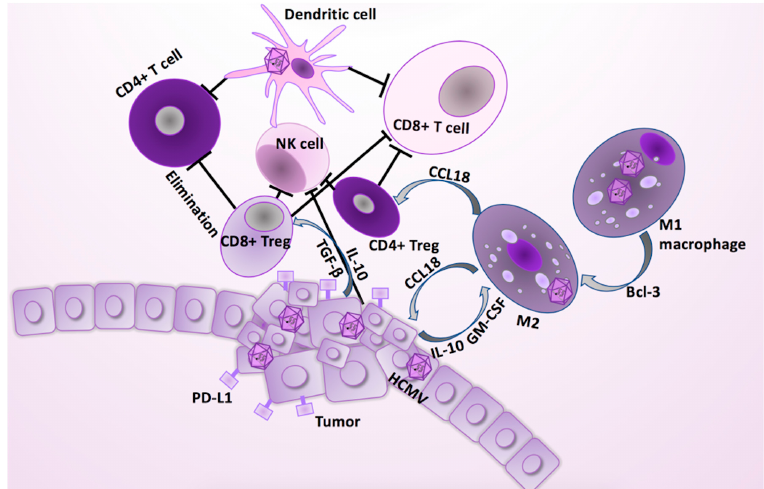
Figure 3. HCMV infection affects several cell types in the tumor. HCMV infection in epithelial cells is pro-tumorigenic, and contributes to the polarization of M1 to M2 macrophages or TAMs. The key TAM-mediated immunosuppressive effects are related to TAMs’ ability to recruit the CD4+ T regulatory (Treg) cells. In addition , tumor cells secrete immunosuppressive cytokines, such as TGF- β and IL-10, which are conductive to proliferation of the TAMs and induction of the CD8+ Treg cells [43]. TAM/Treg shift results to unfavorable, immune suppressive effects, resulting in tumorigenic tolerization and immune escape, thereby promoting cancer progression [43,53]. The CD8+ Tregs can eliminate the activated tumor specific CD4+ T cells, and inhibit actions of both CD8+ T cells and NK cells. The CD4+ Tregs can counteract both the tumor specific CD8+ CTL, and B cell activation and proliferation. HCMV infection and IL-10 secretion from the tumor cells promote an immature phenotype in dendritic cells, which contributes to the reduced antigen-presenting capacity, and increased elimination of the activated T cells through Fas/FasL and TRAIL pathways [42]. The tumor escape is supported when the aberrant activation of the T-cell receptor alone in mature T cells produces a long-lived state of functional unresponsiveness, anergy. Tumor cells express death ligands (PD-L1), of which receptors are expressed on the surface of the immune cells, contributing to the lower proliferation, cytokine production, and their cytotoxic abilities. Clinically, an increased frequency of Tregs is associated with BC progression, histological grade, estrogen receptor negativity, HER-2 positivity, and molecular subtype in BC [55]. HER-2 positive BC and TNBC subtypes have significantly higher amounts of Treg cells, and decreased levels of CD8+T cells compared with the luminal subtype [55]. The extent of Treg cells also predicts worse outcome in TNBC patients [56]. Complete clinical response is associated with the disappearance of Tregs in breast carcinoma, further supporting evidence of substantial immuno-suppressive capabilities of Tregs in the breast tumor microenvironment [57]. The extent of the presence of CTLs similarly predicts improved responses to certain therapies, including chemotherapy, particularly in TNBC, and to trastuzumab in HER-2 positive BC. This also applies to the pathological complete response rate to